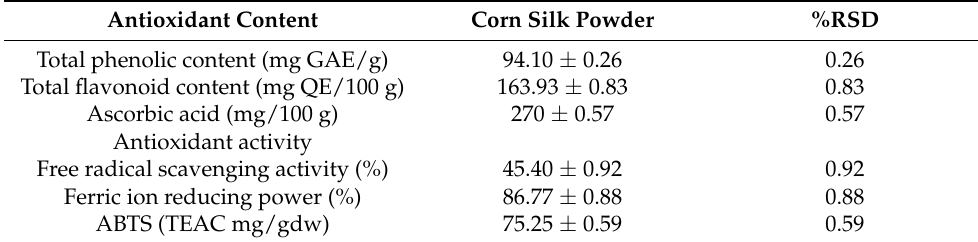
Table 3. The antioxidant profile of corn silk powder. Antioxidant